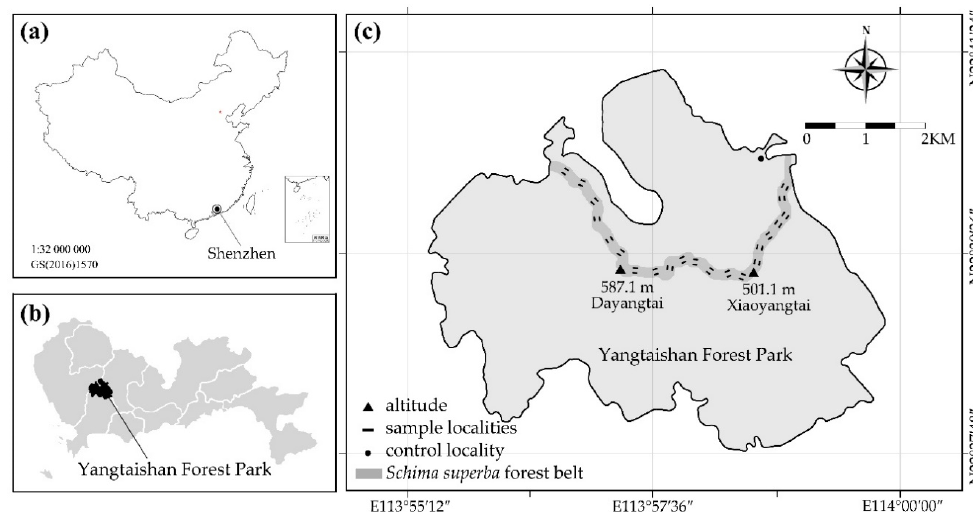
Figure A1. Location map of the study area. ( a ) The location of Shenzhen in China. ( b ) The location of Yangtaishan Forest Park in Shenzhen. ( c ) The study area of Yangtaishan Forest Park, the control locality was used to measure the compared climate data. Table A1. List of bryophyte species, tree and subplot frequencies, and their total coverage.